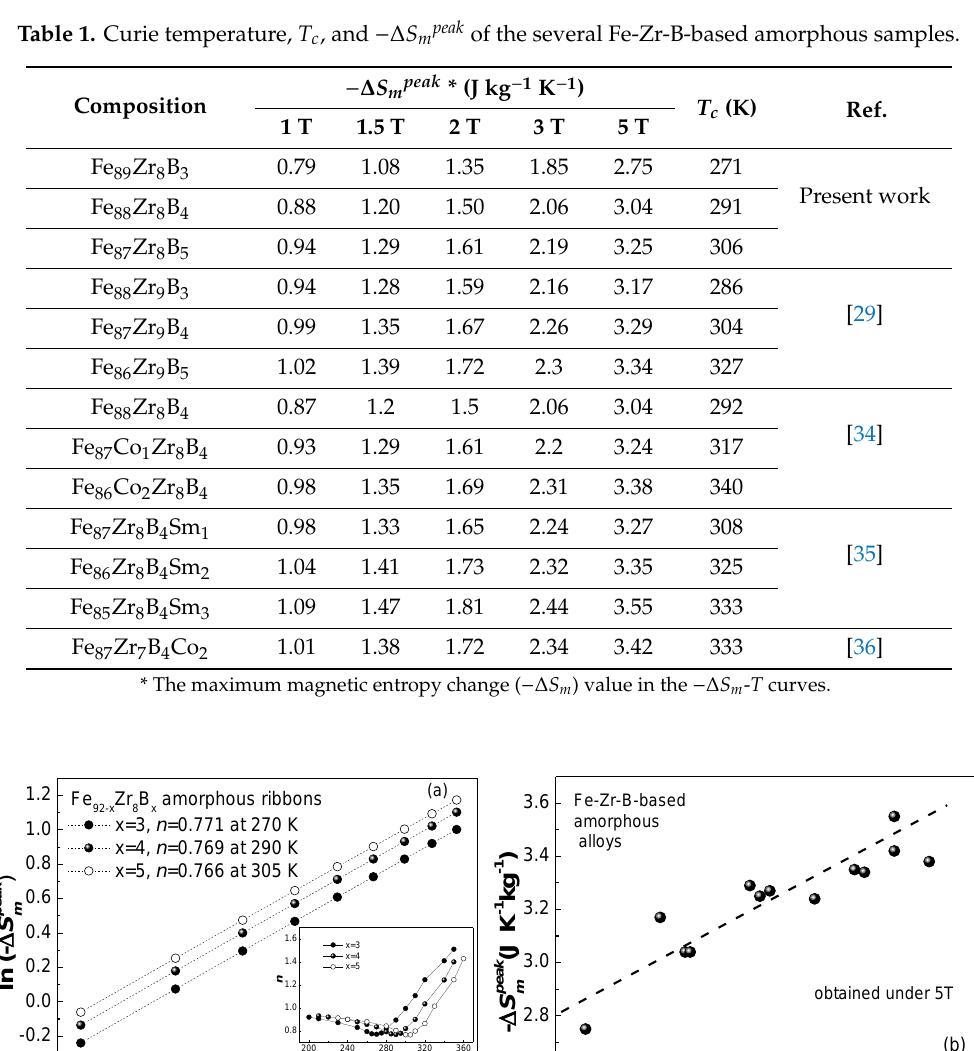
0.0 0.2 0.4 0.6 0.8 1.0 1.2 1.4 Figure 6. ( a ) The −Δ S mpeak ∝ H n relationship of the Fe 91-x Zr 9 B x (x = 3, 4, 5) amorphous alloys at T c , the inset is the n - T curves of the three amorphous alloys; ( b ) the −Δ S mpeak (under 5 T) vs. T c plots and the linear fitting (dash line) these plots in several Fe-Zr-B-based amorphous samples (listed in Table 1).